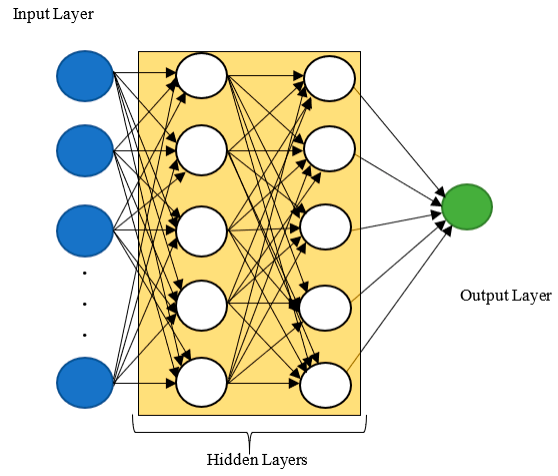
Figure 4. Deep Artificial Neural Network.